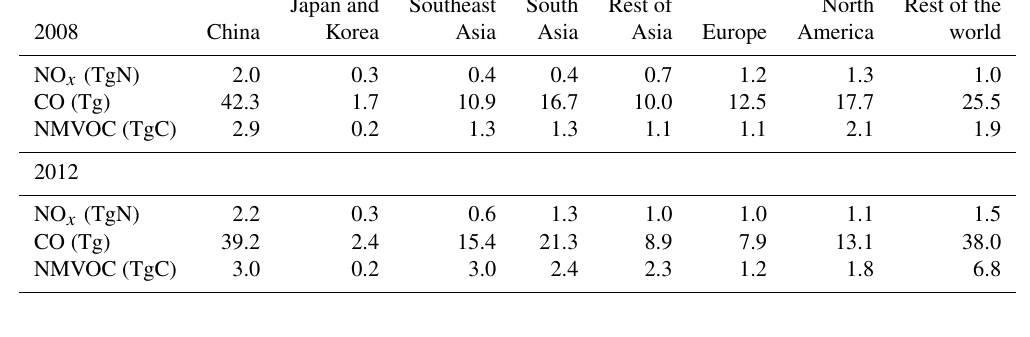
Table 5. Springtime anthropogenic emissions of NO x , CO, and NMVOC in 2008 and 2012 in each source region defined in Fig. 1. Japan and Southeast South Rest of